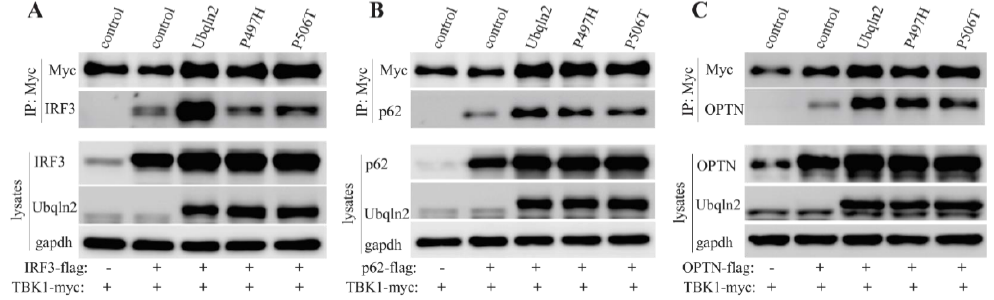
Figure 5. Mutant UBQLN2 impairs TBK1 interactions with partner proteins. HEK-293T cells were co-transfected with TBK1-myc and IRF3-flag or p62-flag or OPTN-flag as well as wild-type or mutant UBQLN2-3xFlag expression vector or empty vector. Harvested cells 48 h after transfection. IP with anti-c-myc resins (Myc-IP) followed by immunoblotting and probed with indicated antibodies. ( A ) Myc-IP to pull down IRF3. ( B ) Myc-IP to pull down p62. ( C ) Myc-IP to pull down OPTN.